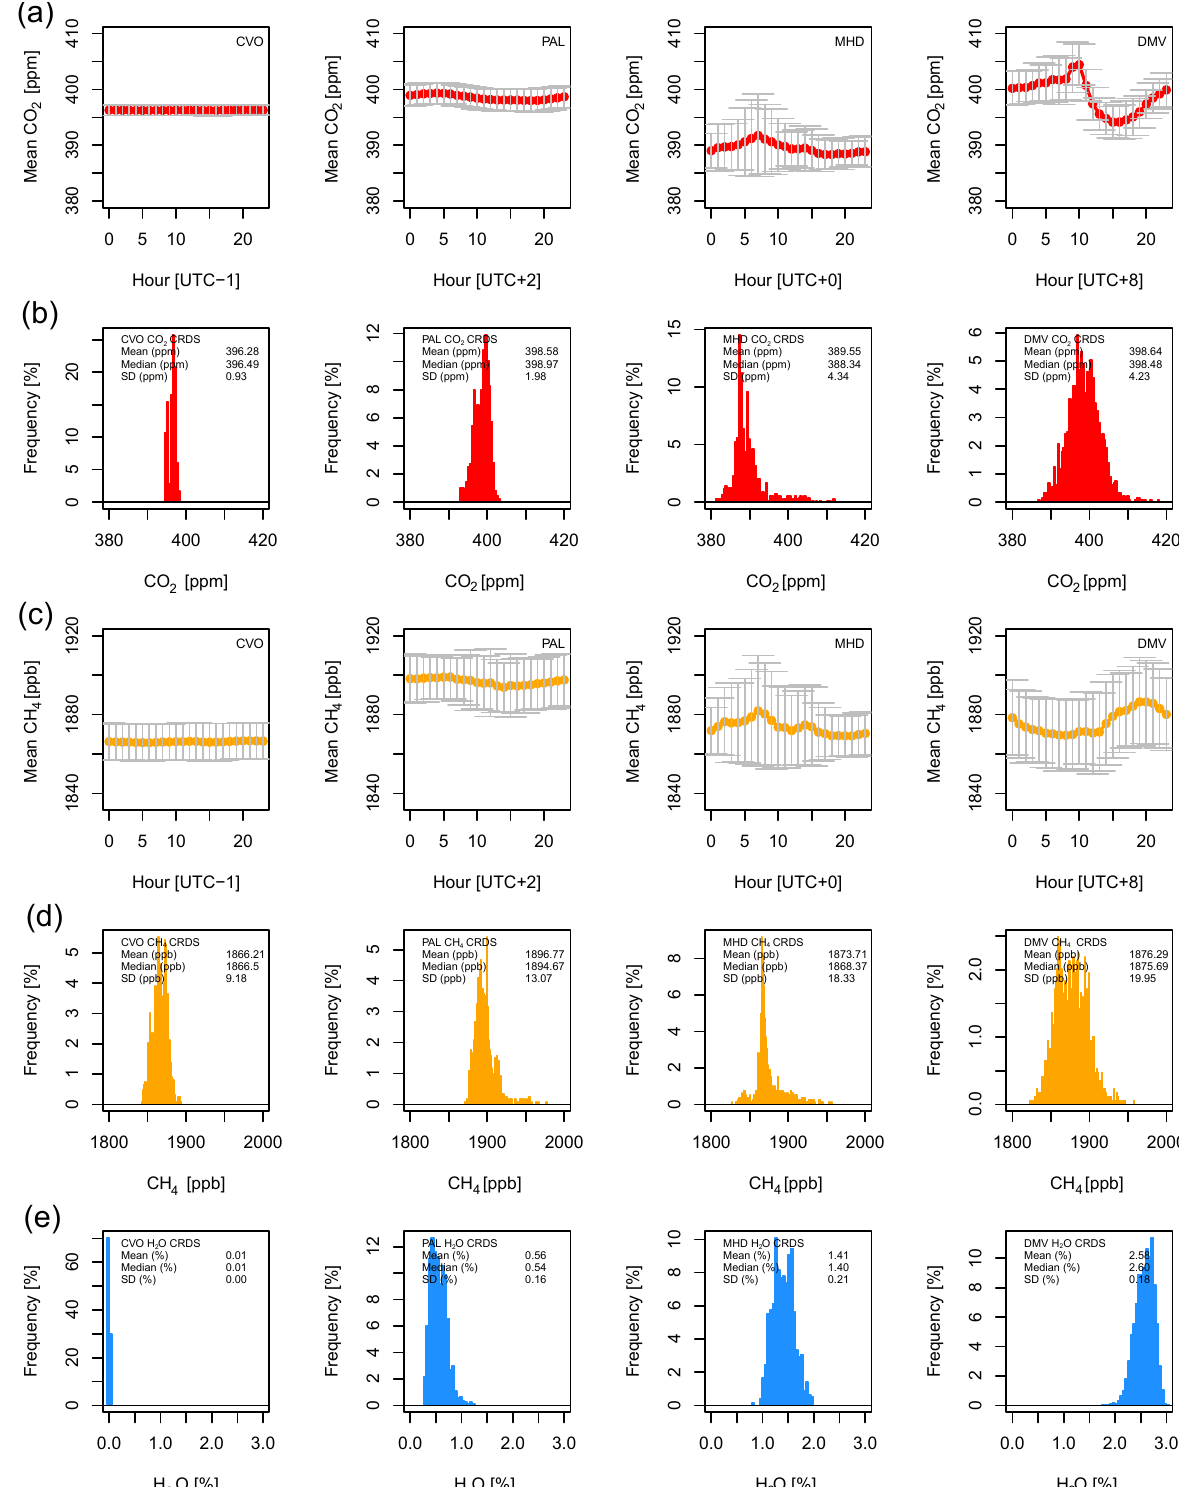
Figure 5. (a) Mean CO 2 diurnal variation measured during the comparison campaigns at CVO, PAL, MHD and DMV with the travelling instrument. The error bars are the standard deviation of each hourly value. (b) Frequency distribution of hourly CO 2 mole fractions (bin size 0.5ppm). (c) Same as (a) for CH 4 . (d) Same as (b) for CH 4 , bin size 1ppb. (e) Frequency distribution of the hourly H 2 O content of the atmosphere (bin size 0.05%), except for CVO, where the H 2 O content after the Nafion dryer is